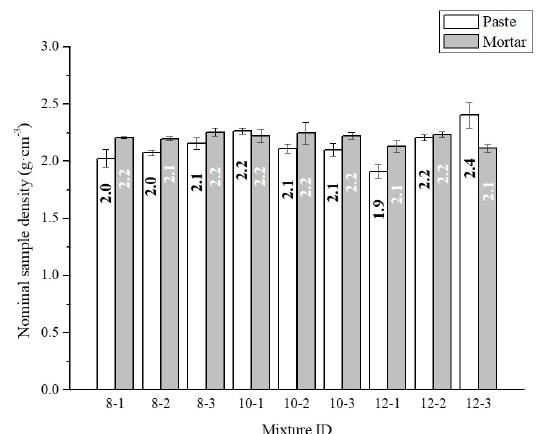
Figure 5. Nominal sample density of alkali-activated